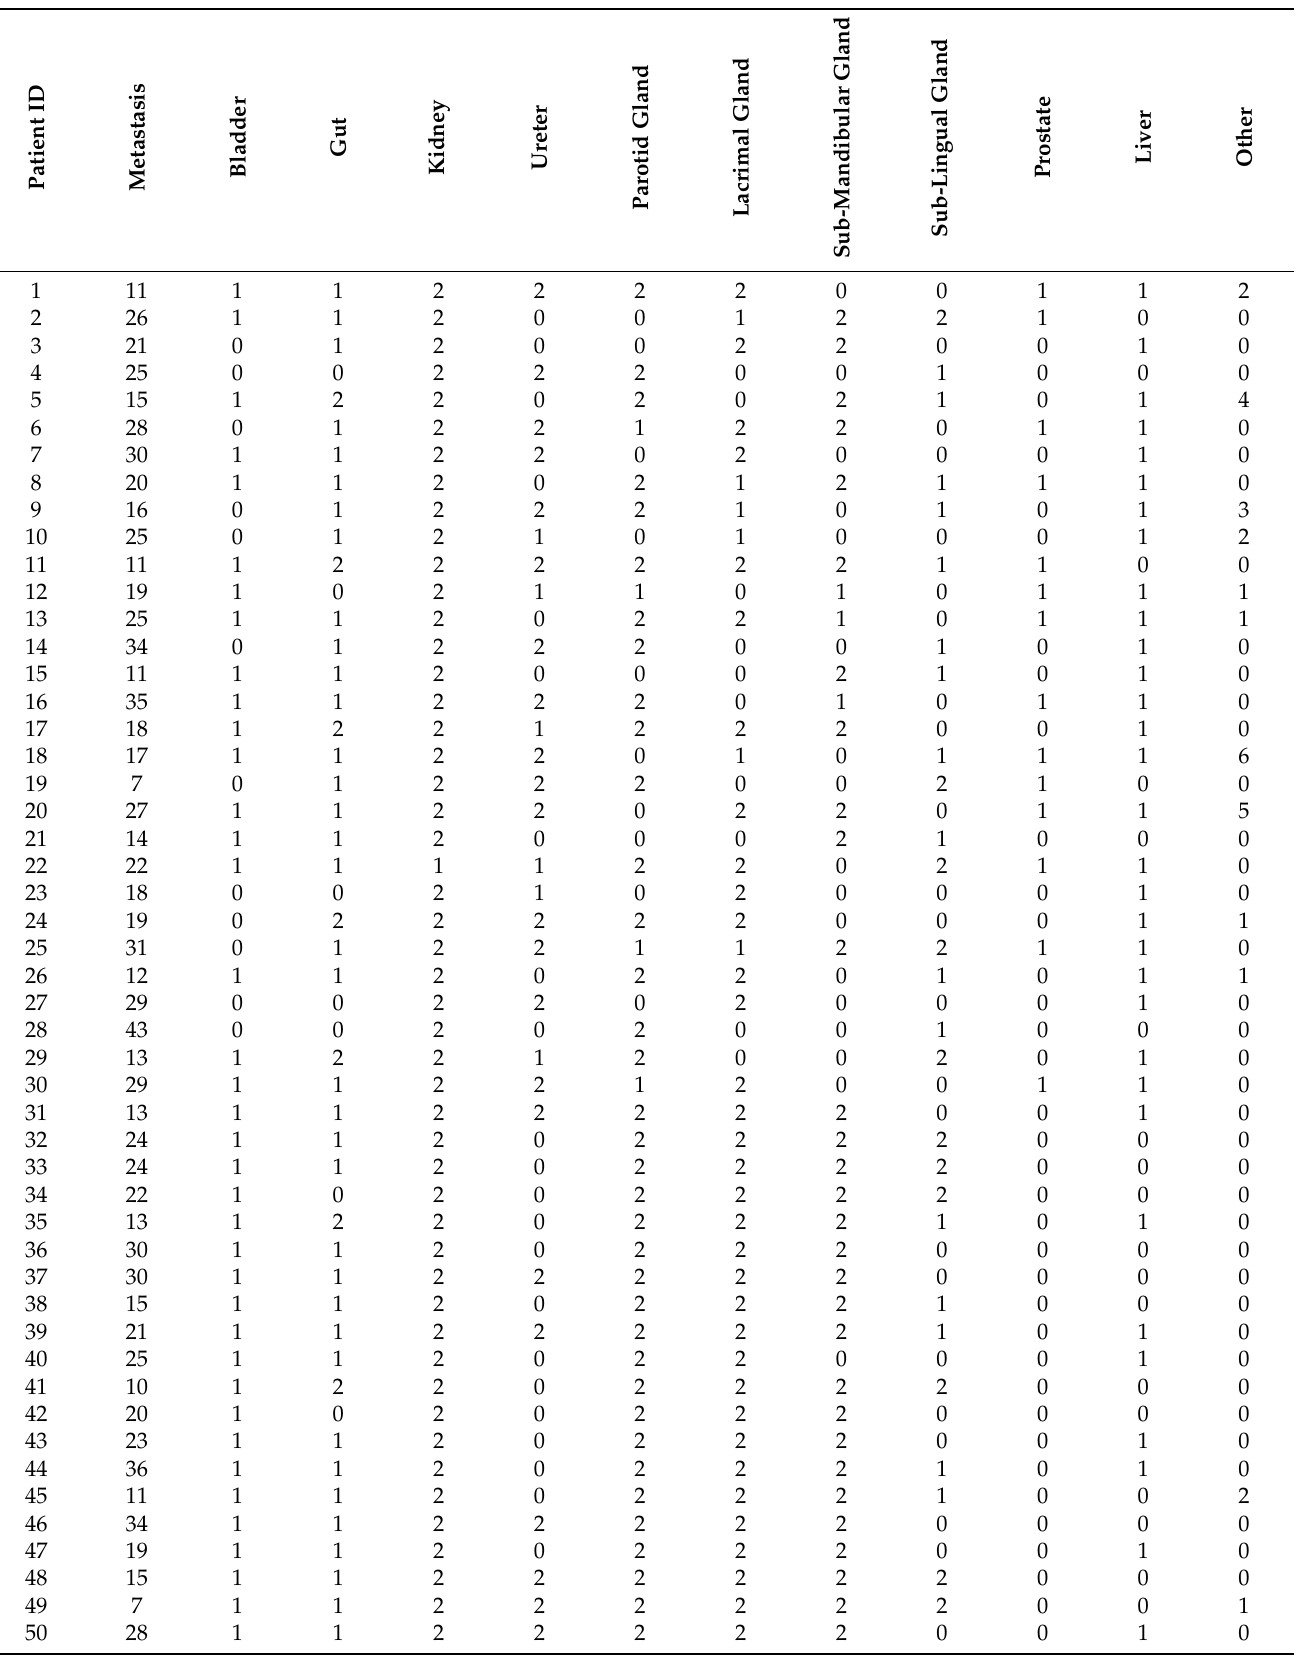
Table 3. The distribution of hotspots throughout the training cohort